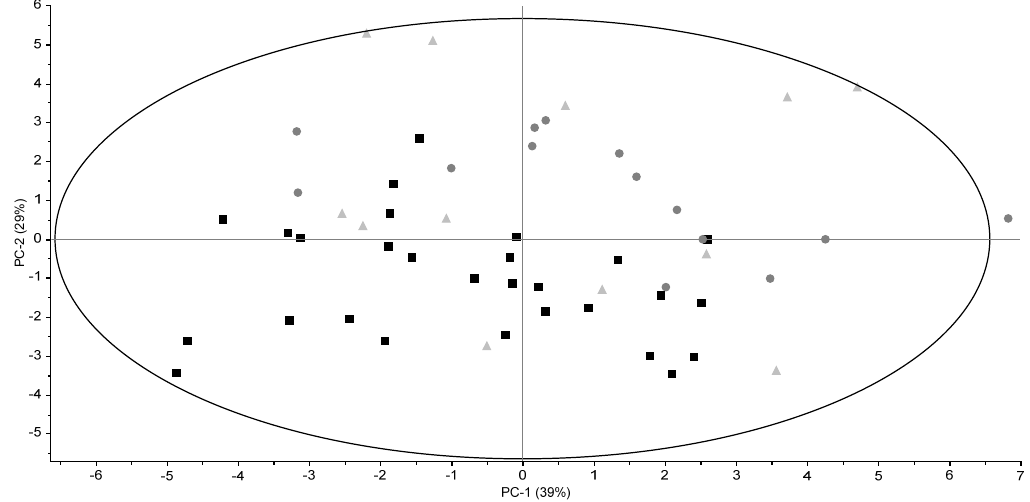
Figure 1. Principal Component Analysis (PCA) score plots of TG profiles for conventional (black square), organic (dark grey round), and grass (light grey triangle) retail full-fat butters.